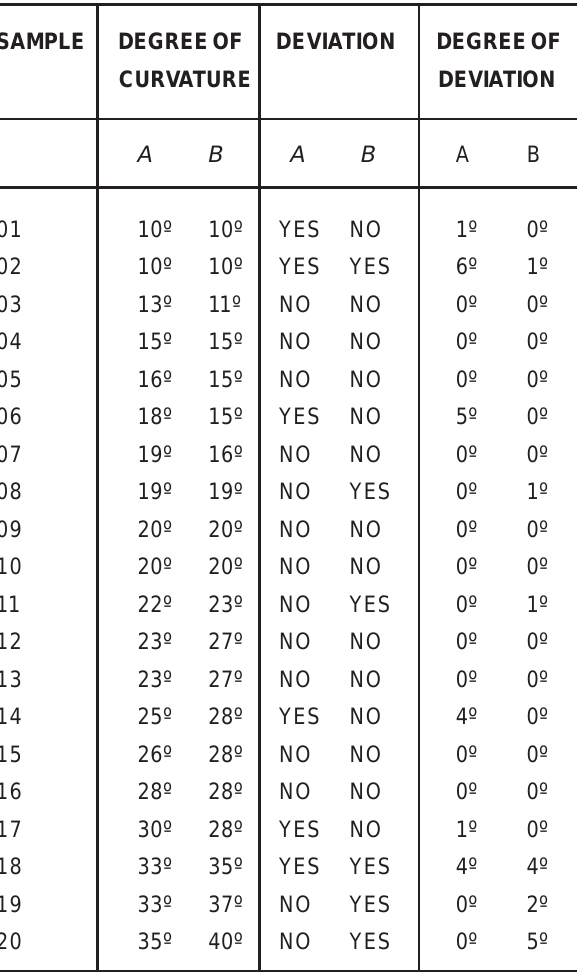
TABLE 1 - Group A, degree of curvature of the roots, presence and degree of apical deviation for the automated system with continuous motion (Pow R); Group B, degree of curvature of the roots, presence and degree of apical deviation for the automated system with alternate motion